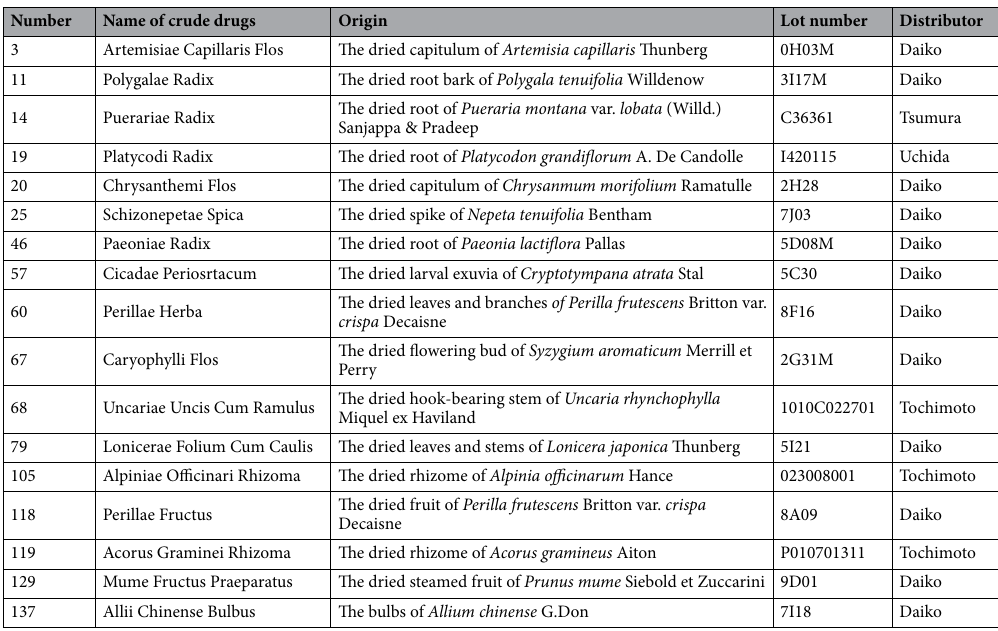
Table 1. List of hit crude drugs. All crude drugs are registered in the Japanese Pharmacopoeia 17th Edition or the Japanese standards for non-Pharmacopoeial crude drugs, 2015. Daiko Shoyaku (Nagoya, Japan),